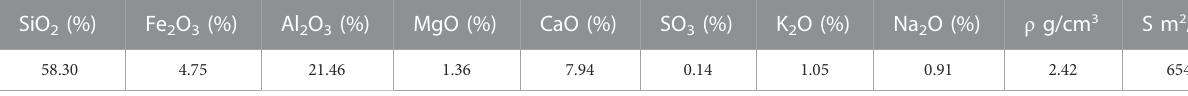
TABLE 2 Chemical composition and physical properties of fl y ash. SiO 2